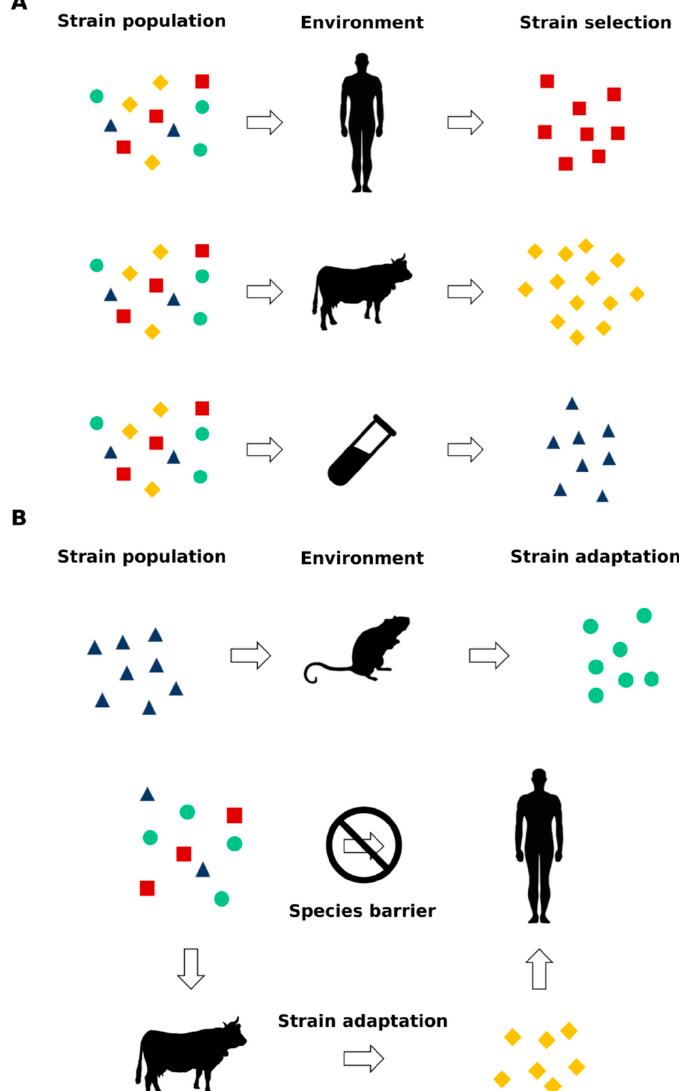
Figure 2. The prion and prion-like strain selection or adaptation: ( A ) According to the replication environment, one prion or prion-like species (i.e., red square in human, yellow diamond in cattle and blue triangle in vitro) present in the initial prion strain population can prevail on the others and be selectively amplified. This phenomenon could manifest in vivo in different animal species, probably influenced by differences in the PrP C sequence of the host, or in vitro according to different experimental settings. ( B ) The appearance of a new prion or prion-like strain can depend on the mechanism of adaptation. In this scenario, one conformer already present in the initial strain population can change its conformation, adapting to the host environment (e.g., blue triangle transforms into yellow diamond). This phenomenon could also explain how prions escape the species barrier. These two processes are not mutually